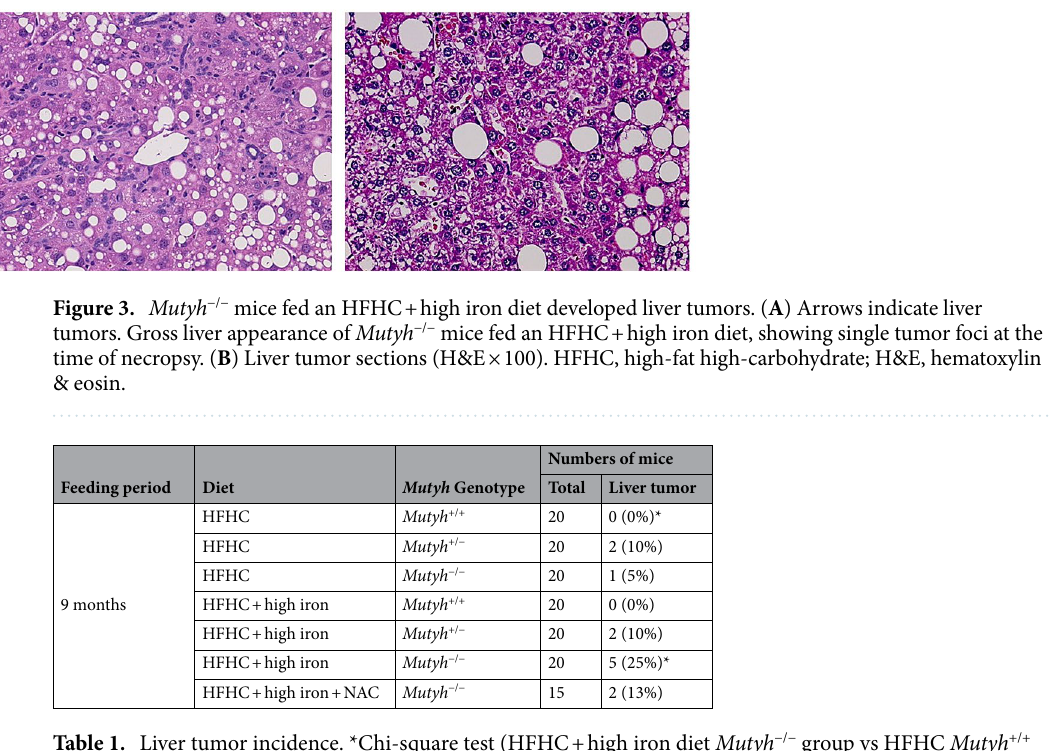
HFHC + high iron diet, irrespective of genotype. In the mice fed an HFHC + high iron diet, intrahepatic iron deposition was observed in both the parenchyma and interstitium. The development of hepatic tumors in each group. The liver tumors which developed were whit- ish and solitary, with tumor cells with increased nucleus to cytoplasm ratios and an irregular arrangement of the hepatic cords, as observed with HE staining. Liver tumor morphology was compatible with HCC (Fig. 3). Liver tumors developed in 25% of the Mutyh −/− HFHC + high iron diet group. The incidence of liver tumors was significantly higher in the Mutyh −/− HFHC + high iron diet group than the Mutyh +/+ HFHC diet group or the (Table 1). Administration of N-acetyl L-cysteine (NAC), an antioxidant known to act directly and/or by increas- ing intracellular GSH38, to this group ( Mutyh −/− HFHC + high iron diet group) resulted in a reduction of the incidence of liver tumors by almost half. Only one MUTYH +/+ mouse fed an HFHC diet developed an extrahe- patic tumor, this being in the small intestine. Immunostaining with anti‑4‑HNE antibody and semiquantitative analysis. The 4-HNE index, determined by anti-4-HNE immunostaining, was used to evaluate lipid peroxidation (Fig. 4A). For each geno- type, the index was significantly higher in the HFHC diet groups than the control diet group ( Mutyh +/+ , HFHC